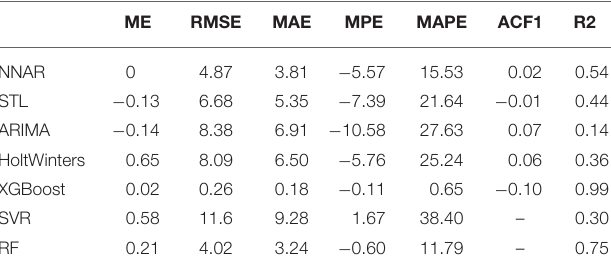
TABLE 1 | Accuracy index of training data.